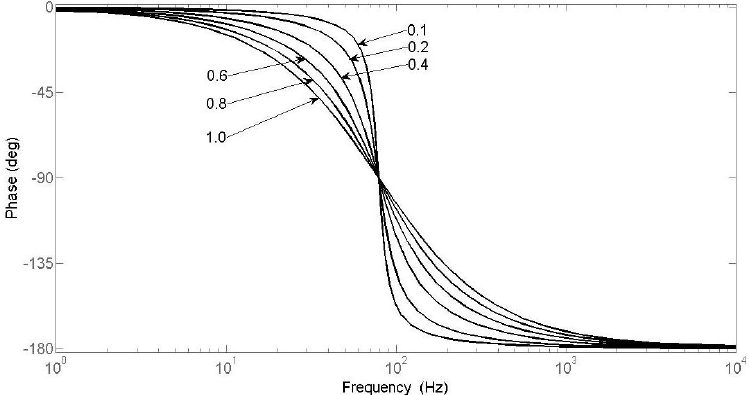
Figure 13. Phase frequency characteristic curves for different damping